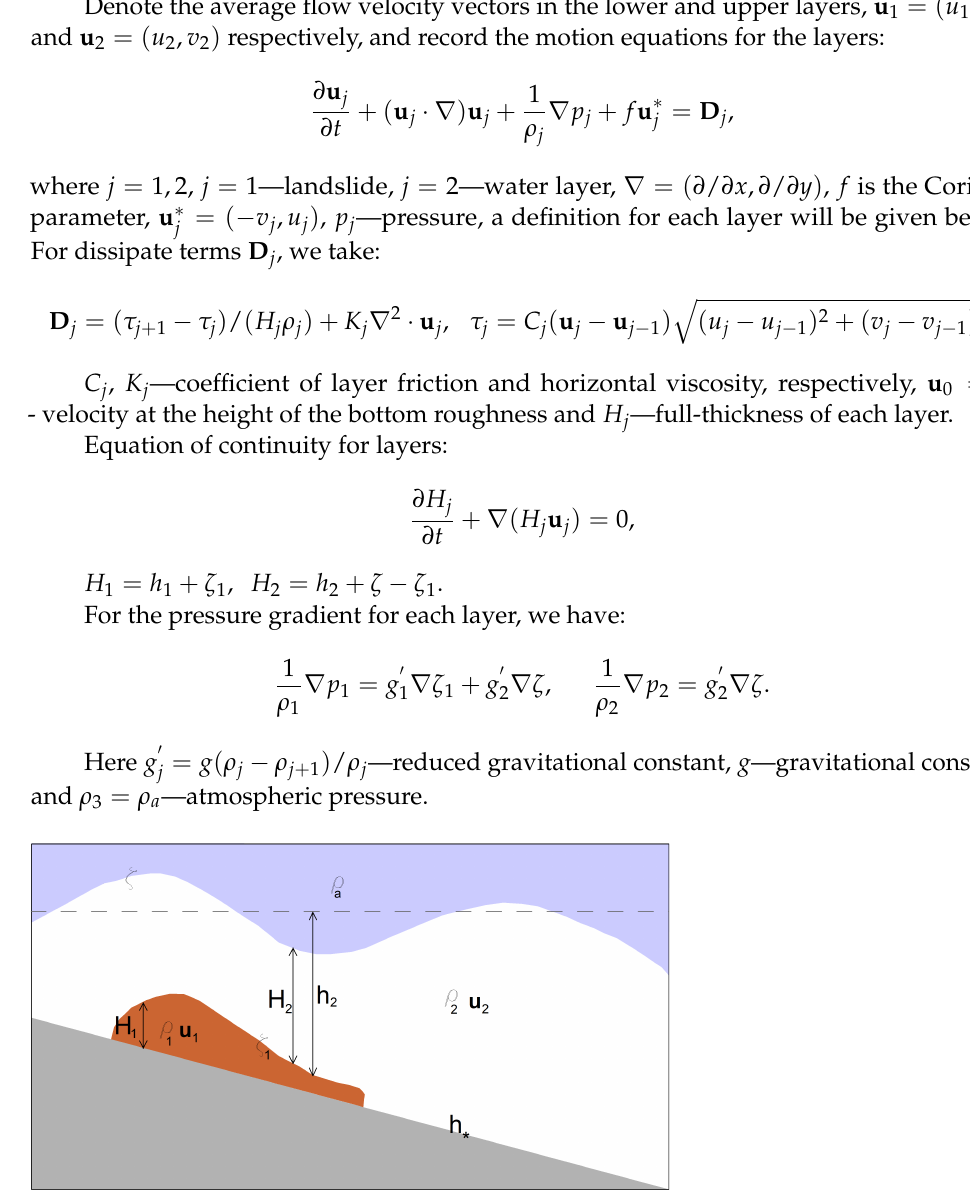
Figure 1. Schematic plot of the two-layer system. Index 1 depicts the landslide, 2—water and